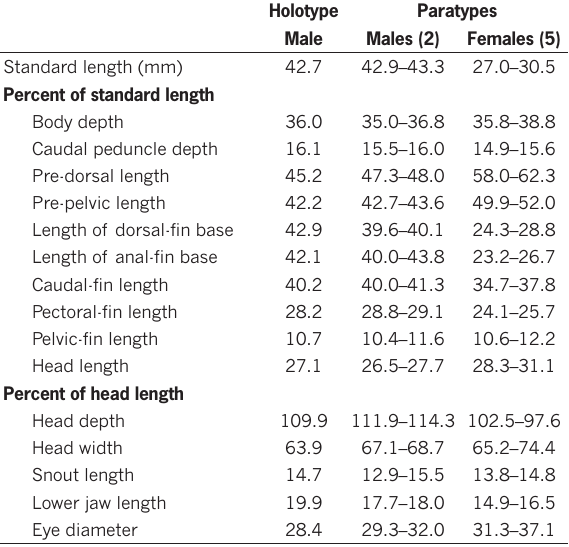
Table 2. Morphometric data of Hypsolebias splendissimus